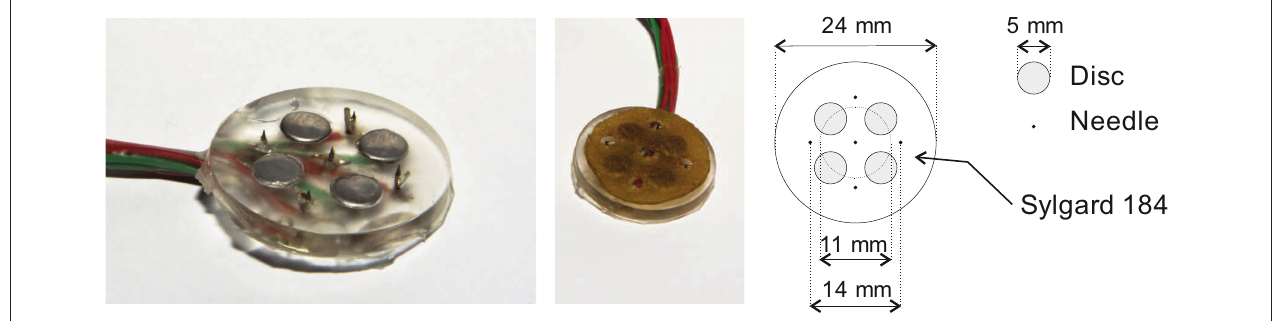
FIGURE 1 | One of the compound electrode arrays which were used in the experiments. Each compound electrode consists of four disc electrodes and five needle electrodes. During experiments, the disc electrodes were covered with a conducting pad which did